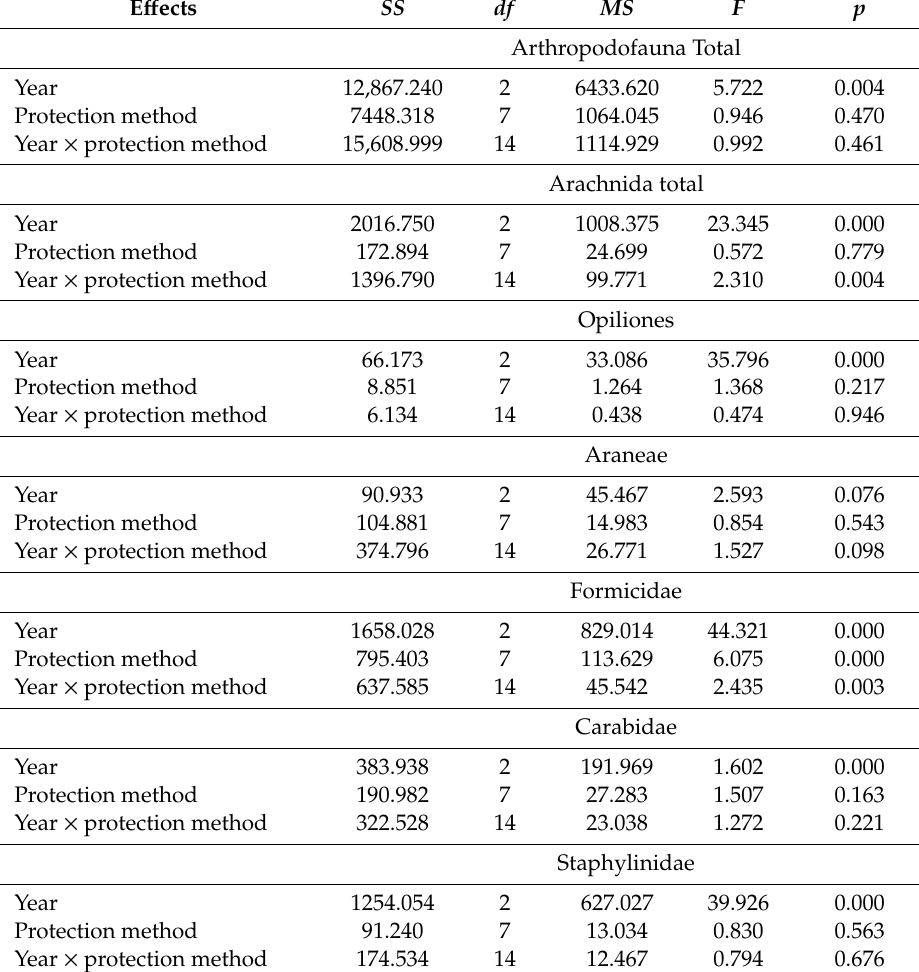
Table 3. Results of the statistical analysis of the presence of investigated arthropodofauna total and selected groups of invertebrates. SS —sum of squares, df —degrees of freedom, MS —mean squares, F —Fisher-Snedecor’s test, p —probability